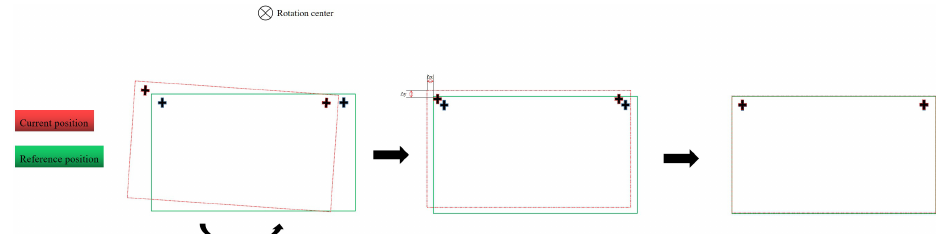
Figure 8. Expected result after the misalignment correction process.